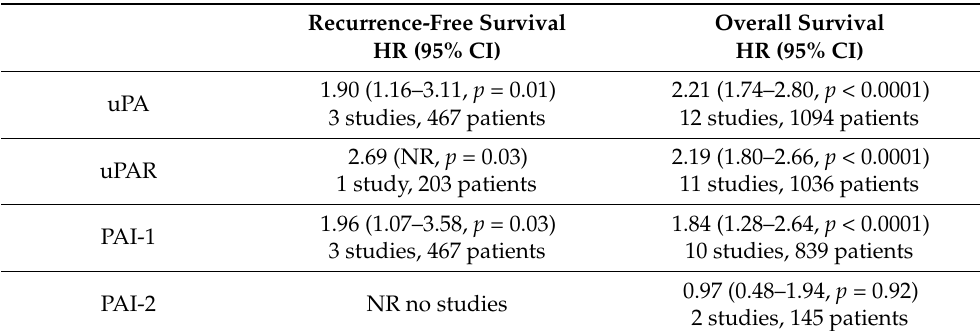
Table 3. Urokinase plasminogen activation system association with relapse-free- and overall sur- vival (combined immunohistochemistry, in situ hybridisation and enzyme-linked immunosorbent assay